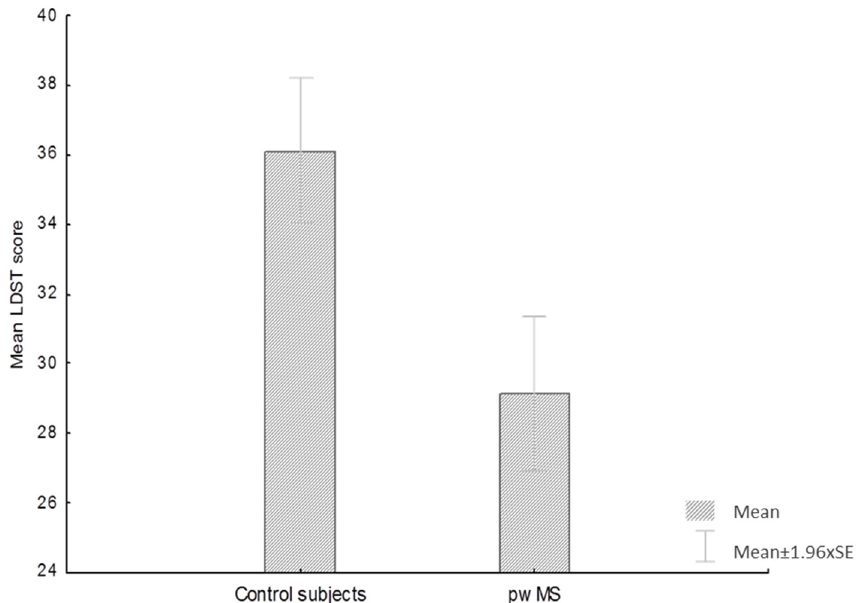
Figure 1. Box plots showing means and standard deviations of LDST in pwMS and control subjects.